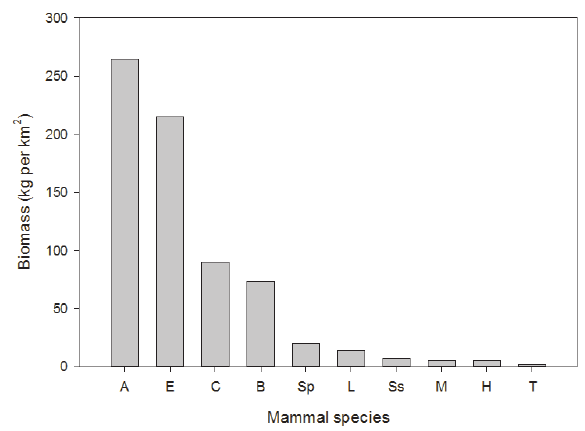
Figure 7: The crude biomass of herbivorous mammals at the Wilpattu National Park (1968-1969) expressed as kilograms per km 2 . Animals are listed in decreasing order of biomass contribution. A= Axis, E= Elephas; C= Cervus, B= Bubalus, Sp = Semnopithecus, L= Lepus, Ss = Sus, M = Muntiacus, H = Hystrix, T = Tragulus . (After Eisenberg and Lockhart, 1972).